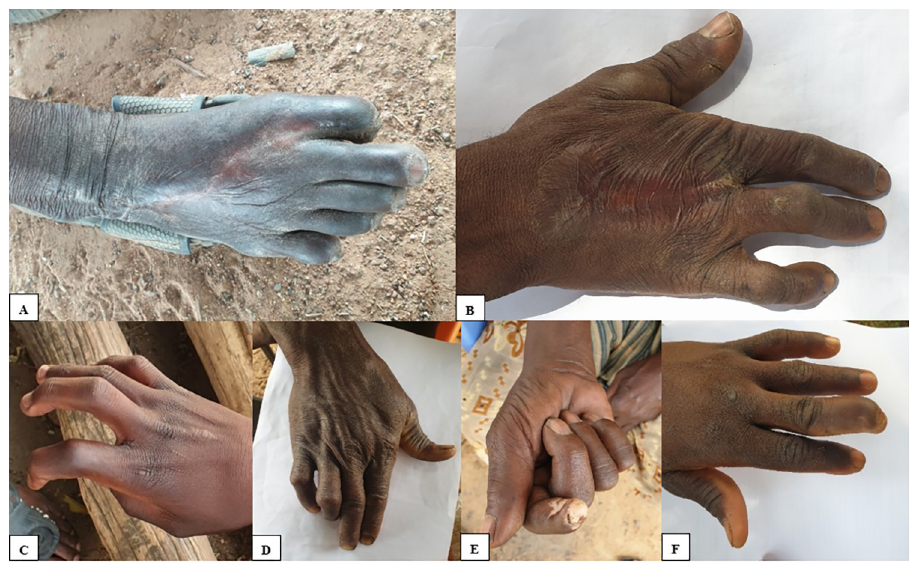
Fig 2. Various localized residual effects of snakebite. A: Amputation at the proximal interphalangeal joint of the big toe (Echis ocellatus reported). B: Amputation of the middle finger (Naja nigricollis reported). C: Contracture deformity of the distal interphalangeal joint of the index finger (Bitis arietans reported). D: Contracture deformity of the proximal and distal interphalangeal joints of the ring and little fingers (Echis ocellatus reported). E: Contracture deformity of the proximal and distal interphalangeal joints of the index finger with a chronic ulcer (snake not seen). F: Contracture deformity of the proximal interphalangeal joint of the middle finger (Bitis arietans reported). This participant did not report to a health facility for treatment. Participants in images A and E reported mild disabilities based on the WHODAS 2.0 total scores. All the other participants reported no disability.